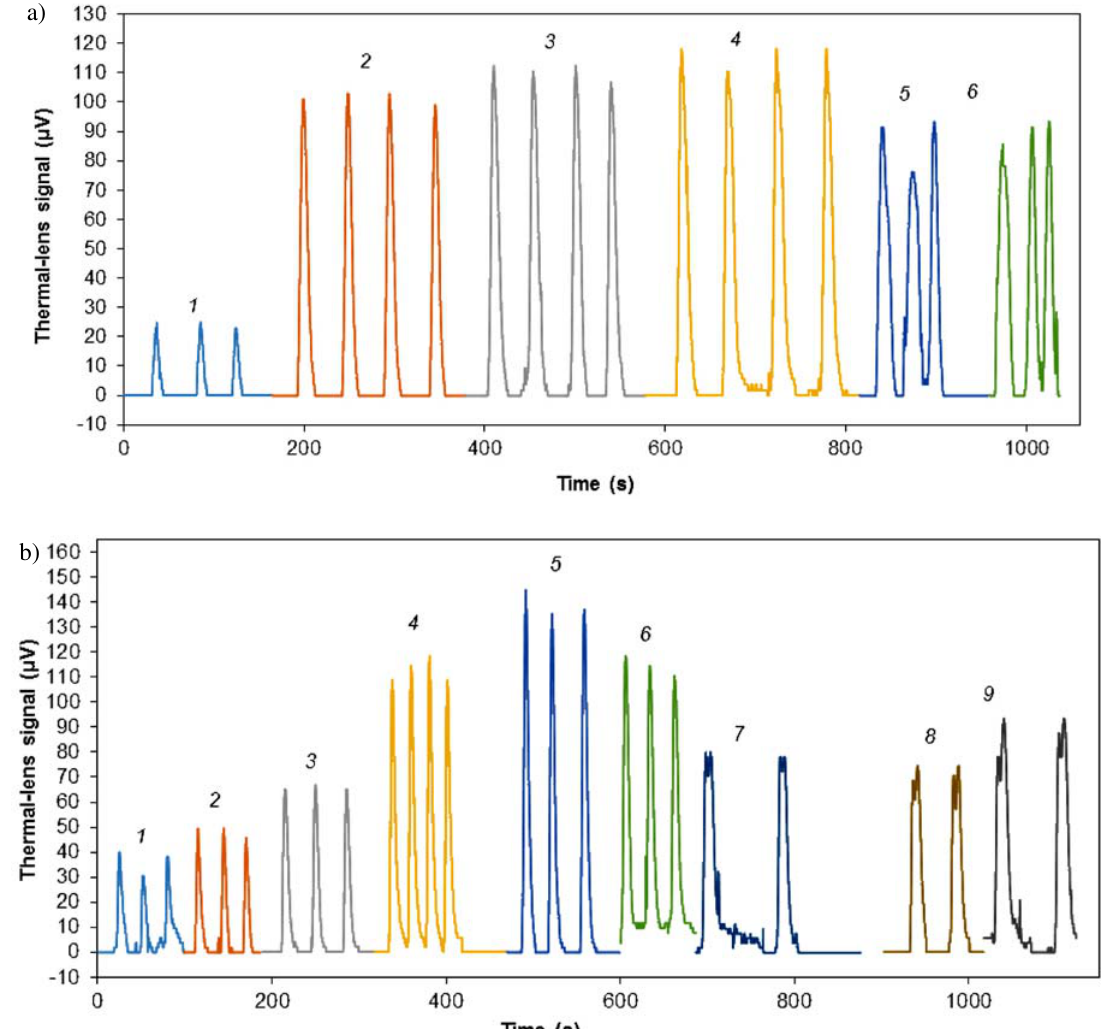
Figure 7. Shapes of thermal-lens signal (with the subtracted background signal) of Cr(VI) (4 μmol L-1) complex with diphenylcarbazide (20 μmol L-1) for various conditions: (a) flow rate, 5 μL min-1, detection position, 29 cm from the mixing point (1, V = 0.2 μL, 2, V = 0.4 μL, 3, V = 0.6 μL, 4, V = 0.9 μL, 5, V = 1.4 μL, and 6, V = 1.6 μL) (b) flow rate, 10 μL min-1, detection position, 29 cm from the mixing point (1, V = 0.2 μL, 2, V = 0.4 μL, 3, V = 0.6 μL, 4, V = 0.9 μL, 5, V = 1.4 μL, 6, V = 1.6 μL; 7, V = 2.0 μL; 8, V = 2.2 μL; and 9, V = 2.5